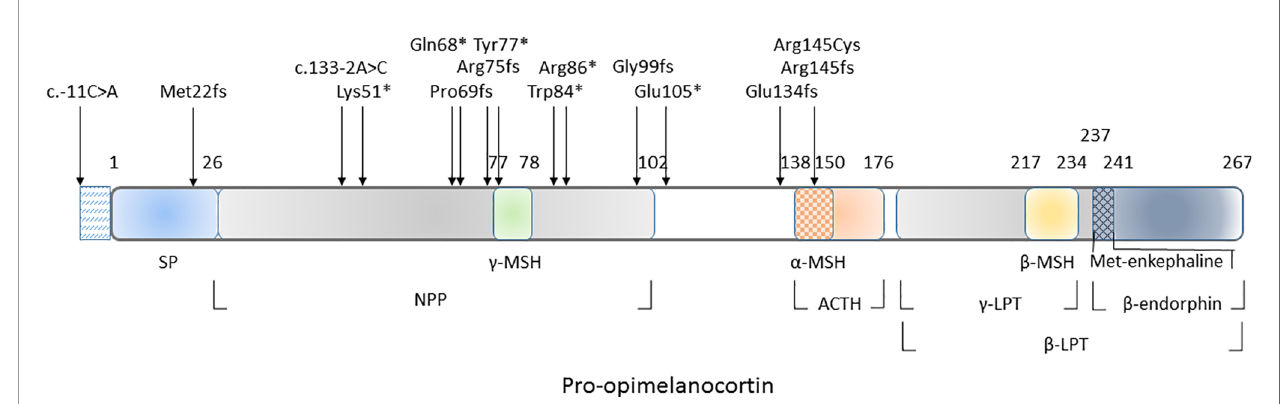
FIGURE 5 | Schematic representation of POMC-derived peptides and genetic variants associated with autosomal recessive POMC de fi ciency. ACTH, corticotropin; b -LPT, lipotropin b ; g -LPT, lipotropin g ; a -MSH, melanotropin a ; b -MSH, melanotropin b ; g , MSH, melanotropin g ; NPP, N-terminal peptide of proopiomelanocortin; SP,